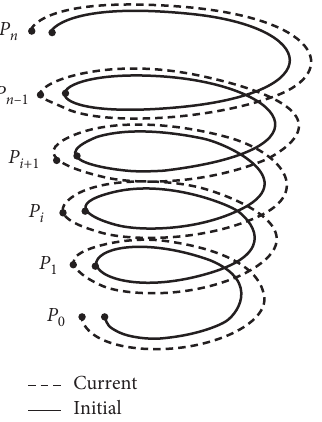
Figure 2: The schematic of the helix spring in the initial and current